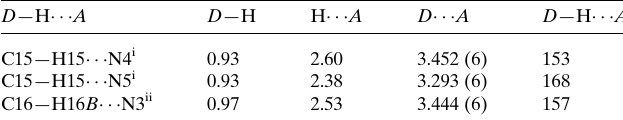
Table 2 Experimental